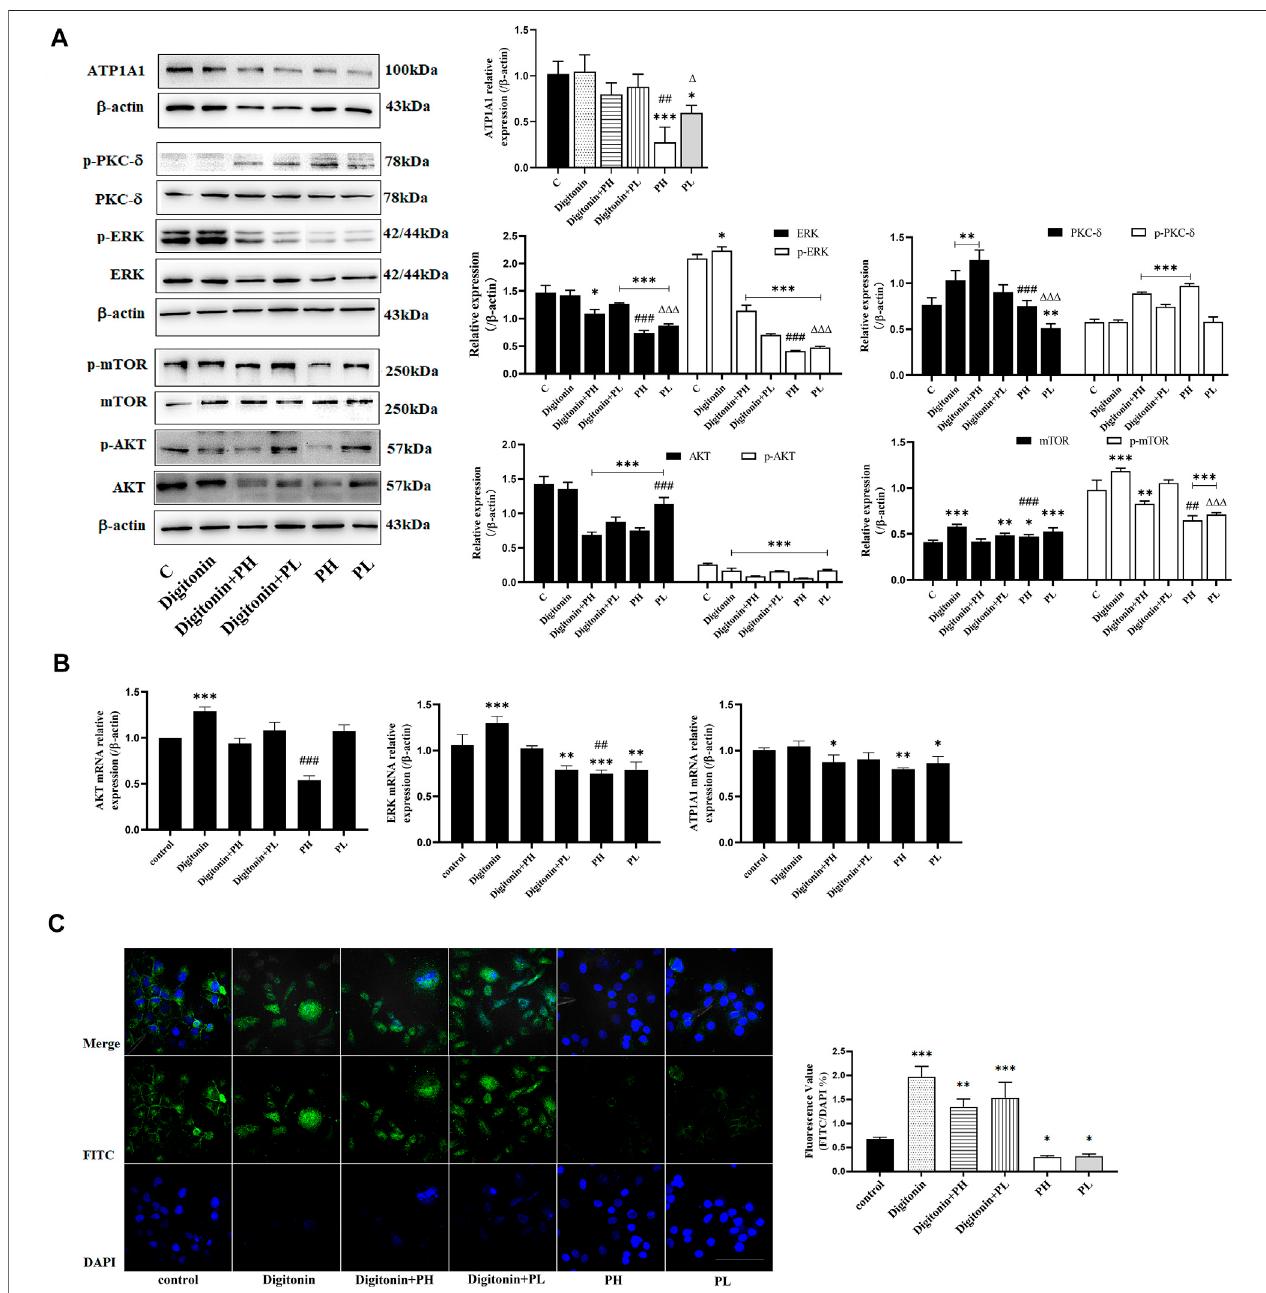
FIGURE5| PNSanddigitoninregulatedtheexpressionofproteinsandmRNAofATP1A1/AKT/ERKsignalingpathways.Digitonin:10 nmol/L;PH:600 mg/LPNS; and PL: 300 mg/L PNS. (A) The representative image of Western blot after treatment with PNS and digitonin and their quantitative analysis are shown. (B) The relative expression of AKT, ERK1/2, and ATP1A1 by Q-PCR and their quantitative analysis are shown. (C) The fl uorescence image of laser confocal detection of the expression ofATP1A1ontheHepG2cellmembrane(10 × 60).Scalebar (cid:2) 50 μ m.Dataareexpressedasmean ± standarddeviation.* p < 0.05,** p < 0.01,and*** p < 0.001vs. the control group; Δ p < 0.05, ΔΔ p < 0.01, and ΔΔΔ p < 0.001 vs. the digitonin + PH group; # p < 0.05, ## p < 0.01, and ### p < 0.001 vs. the digitonin + PL group.